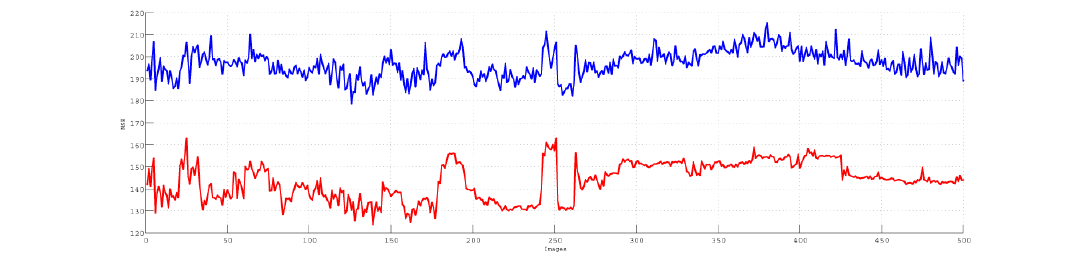
Figure 3. Mean square error (MSE) values for our homomorphic wavelet filter (HWF) and the filtering Butterworth high-pass filter (BHPF). The red line is for the HWF and the blue line is for the BHPF. The 500 consecutive images from our training data are selected in this evaluation.